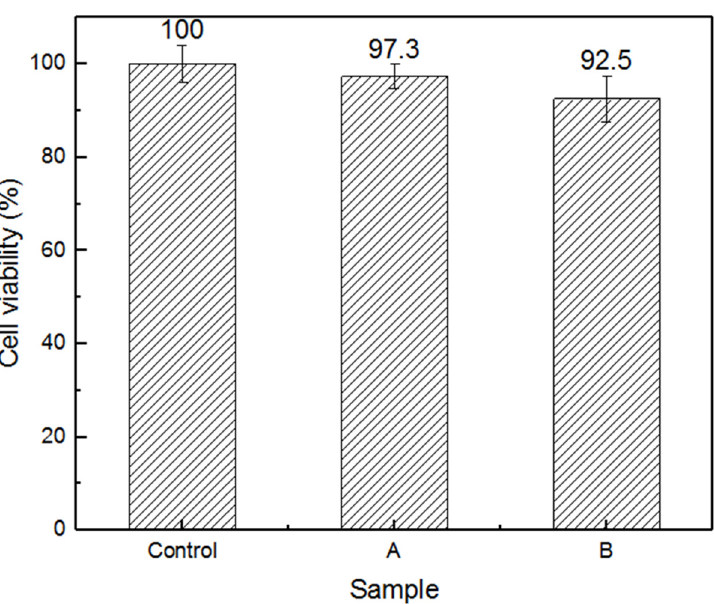
Figure 12. In vitro cytotoxicity of the PP-g-P (AAm-co-AN) after incubation with cells for 48 h at 37 ◦ C. (A) The AAm grafting degree is 101%, and the AN concentration of PP-g-P (AAm-co-AN) is 23%. (B) The AAm grafting degree is 98%, and the AN concentration of PP-g-P (AAm-co-AN) is 25%. The control was the cells cultured with DMEM medium. The ANOVA test showed that there was no significant difference between the control, sample A and sample B.